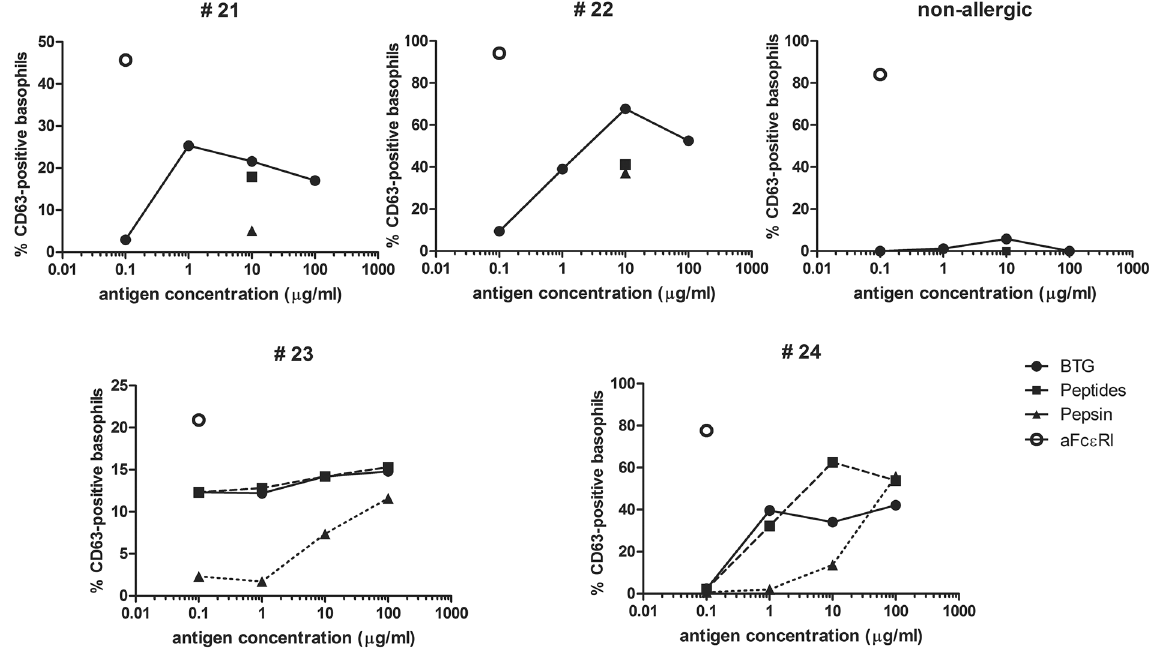
Figure 4. Allergenic activity of α -Gal IgE-reactive peptides. Allergenic activity of α -Gal IgE-reactive peptides, BTG, pepsin and anti-Fc ε RI (positive stimulation control) was determined by basophil activation in blood from four red meat-allergic patients and one non-allergic individual. Degranulation is presented as proportion (%) of CD63-positive out of CD203c-positive cells by flow cytometry (y-axes) in response to different allergen concentrations (x-axes).